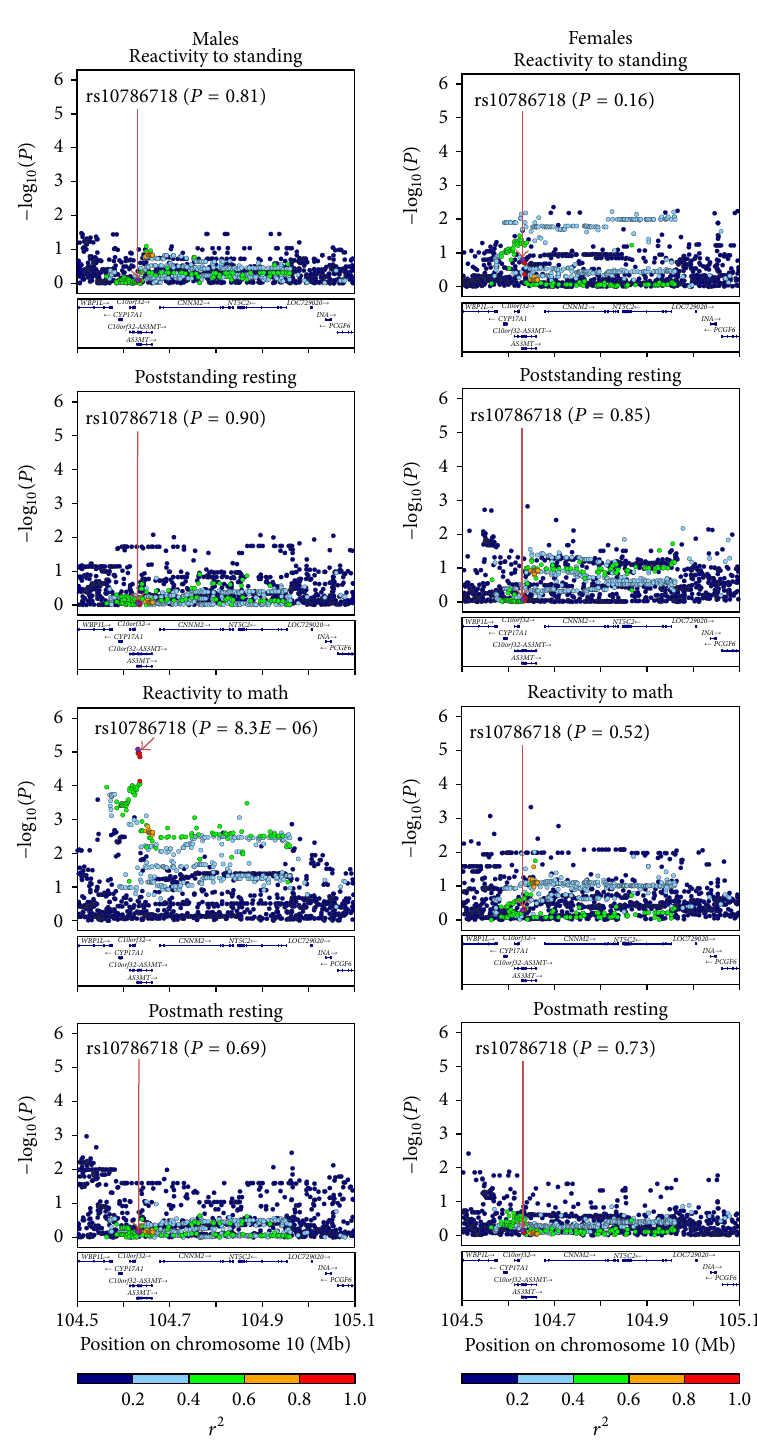
Figure 3: CYP17A1 locus and SBP in response to physical and mental challenges and at rest. Individual points indicate − log 10 ( 𝑃 values) for associations of SNPs within the CYP17A1 locus and studied SBP phenotypes. Plots on the left and right show the results in males and females, respectively. Data were adjusted for age, height, and, when appropriate (SBP reactivity to standing and mental stress), initial SBP. The SNP, rs10786718, demonstrating the strongest association with SBP reactivity to math stress in males is indicated in purple and is the index SNP in all plots. The correlation ( 𝑟 2 ) between this index SNP, rs10786718, and each of the other tested SNPs in the region is shown in red (1 ≥ 𝑟 2 ≥ 0.8), orange (0.8 > 𝑟 2 ≥ 0.6), green (0.6 > 𝑟 2 ≥ 0.4), light blue (0.4 > 𝑟 2 ≥ 0.2), or dark blue (0.2 > 𝑟 2 ≥ 0) colors. Gene positions are indicated at the bottom. The LD was calculated based on the 1,000 Genomes Project (EUR reference panel, March 2012 version); the chromosome positions are based on human genome